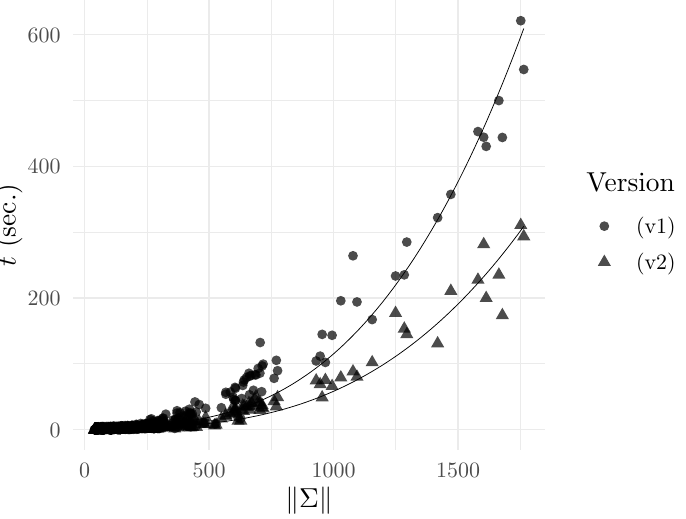
Figure 2. Execution time of versions (v1) and (v2), with cubic adjustment.